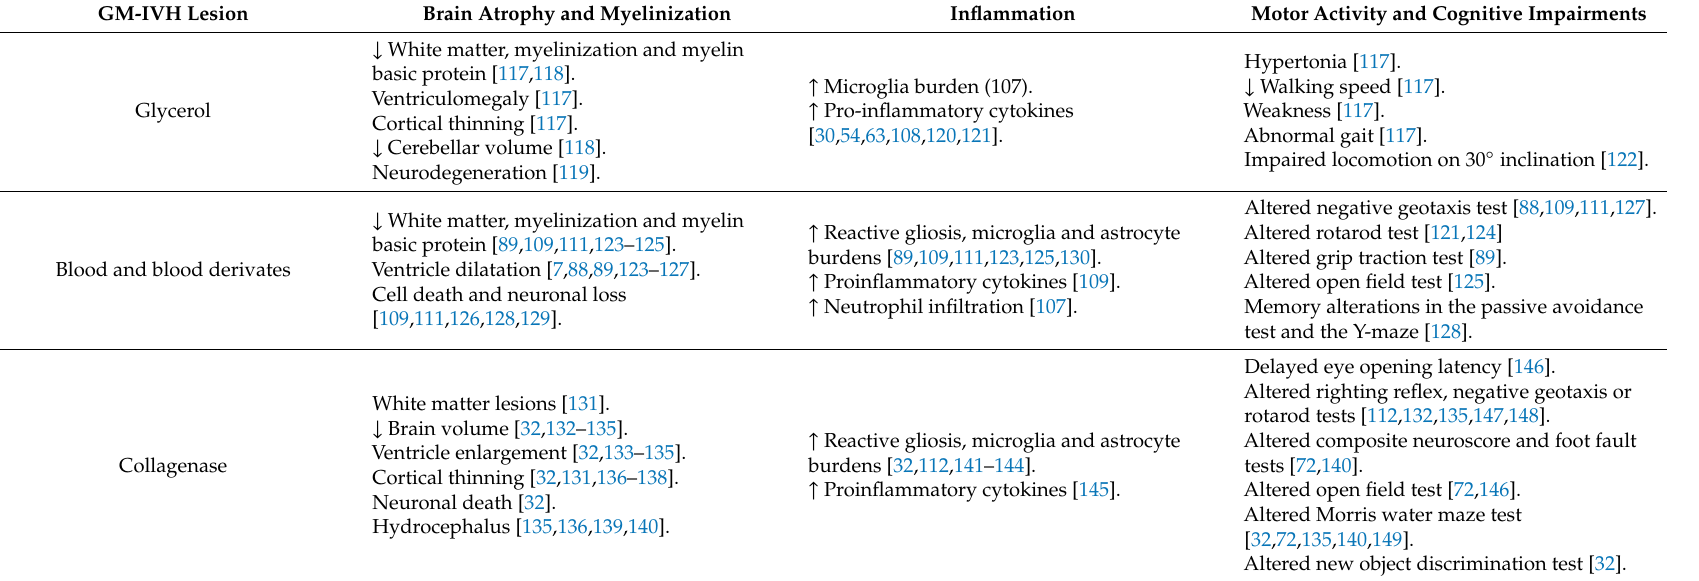
Table 1. Complications associated with GM-IVH induced by glycerol, blood and blood derivates and collagenase lesions. GM-IVH